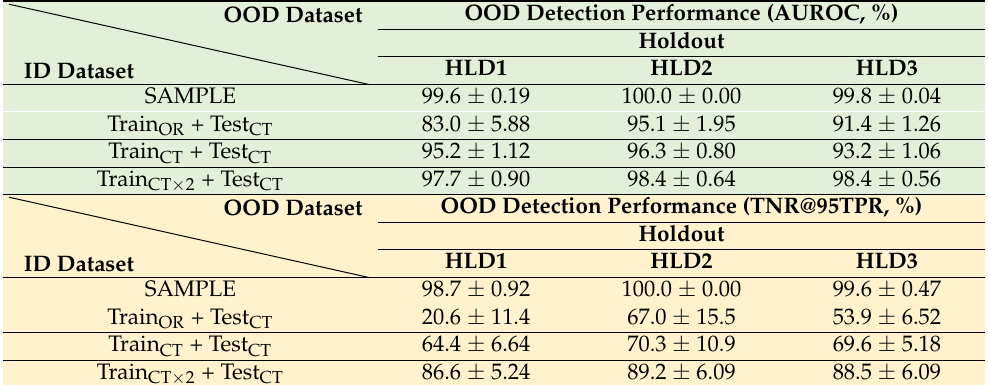
Table 7. OOD detection performance degradation due to background changes in ID test samples, and the positive effect brought by the extra training samples with diverse backgrounds ( K = 1). OOD Detection Performance (AUROC, %)